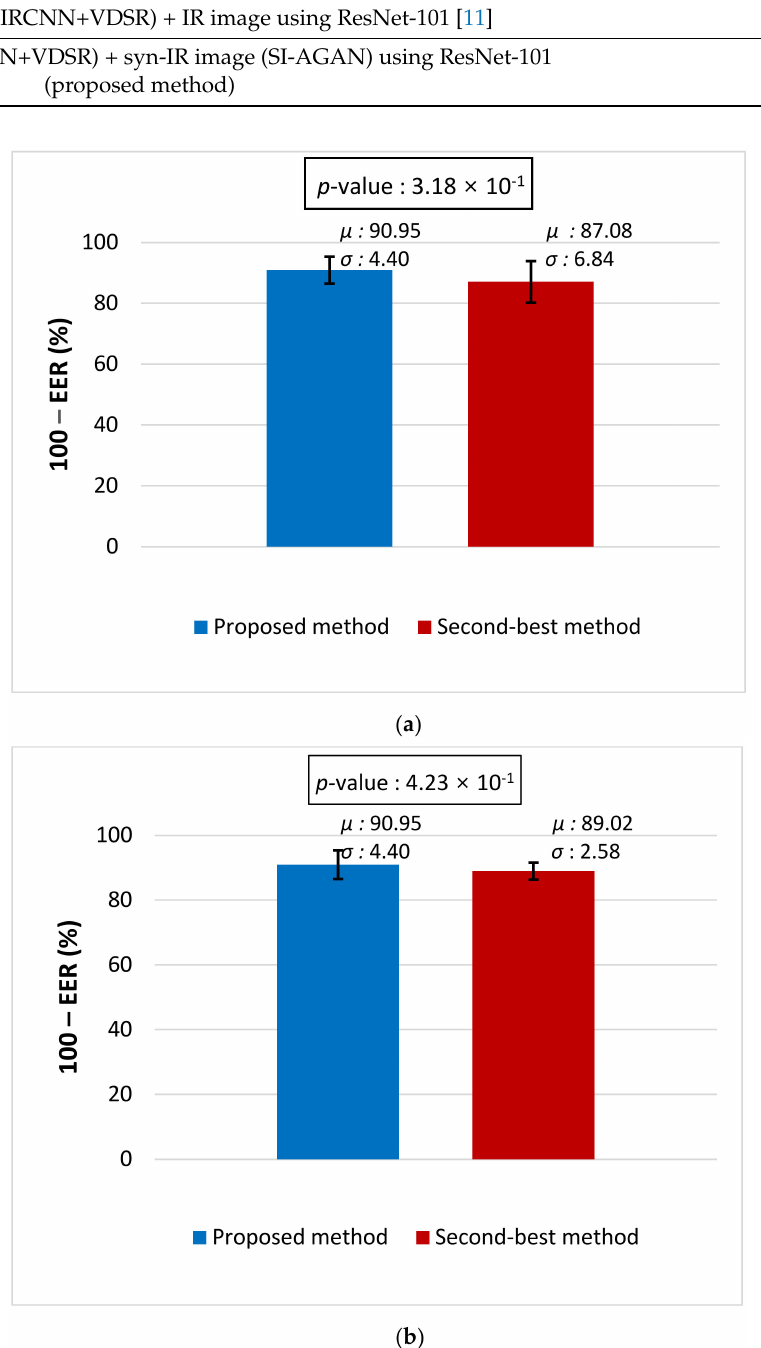
Figure 16. T -test result between our proposed method and the second-best method. ( a ) Comparison between proposed method and Visible-light image(+IRCNN+VDSR) + syn-IR image (AGGAN) [47] in Table 11. ( b ) Comparison between proposed method and Visible-light image (+IRCNN+VDSR) + IR image using ResNet-101 [11] in Table